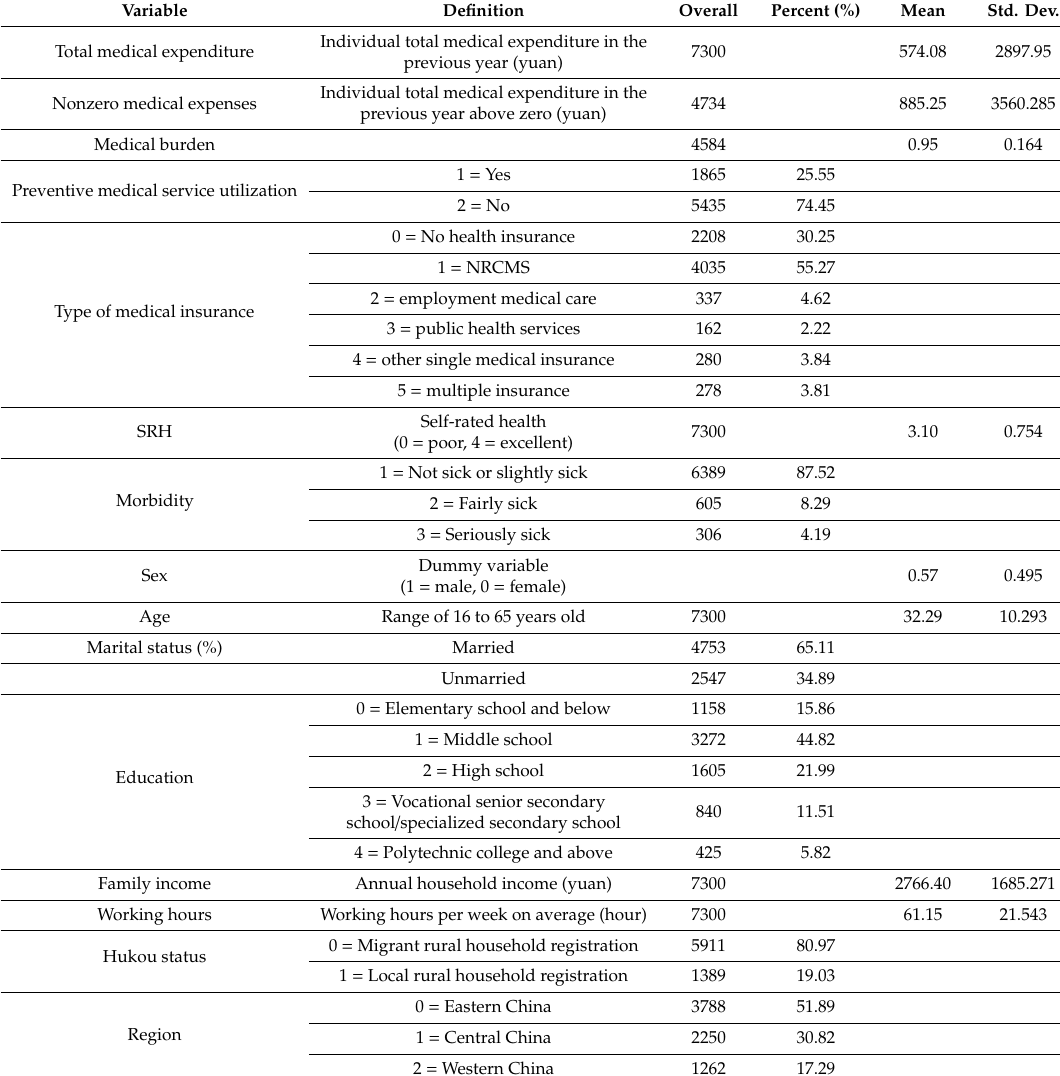
Table 1. Sample summary statistics for the selected